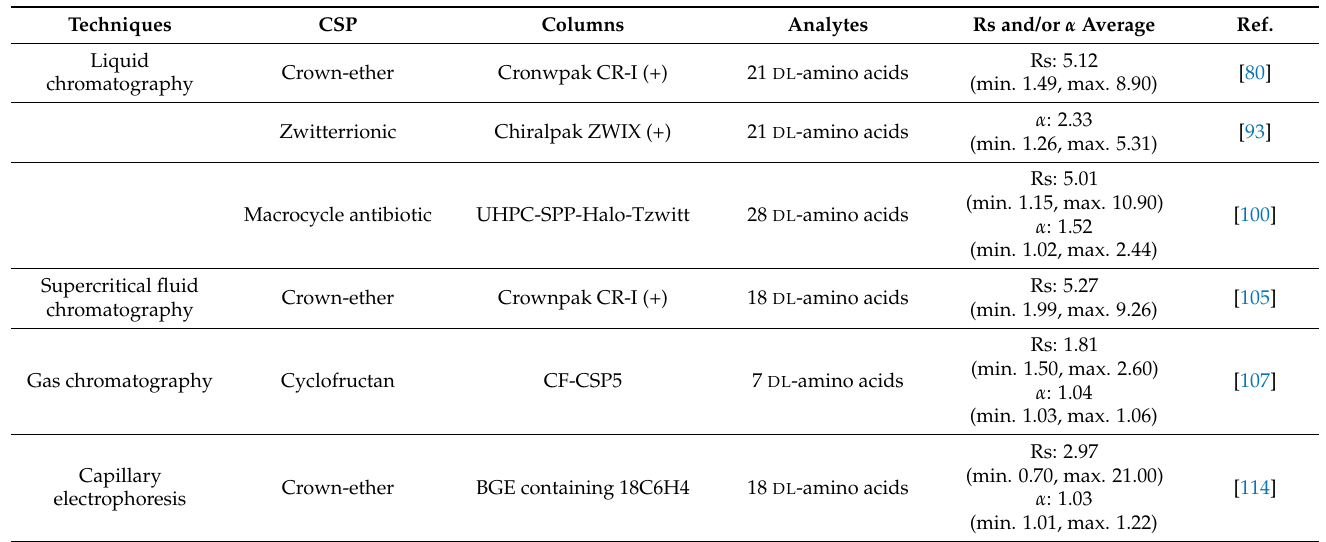
Table 7. Summary of the most efficient techniques for enantioseparation of underivatized DL -amino acids.